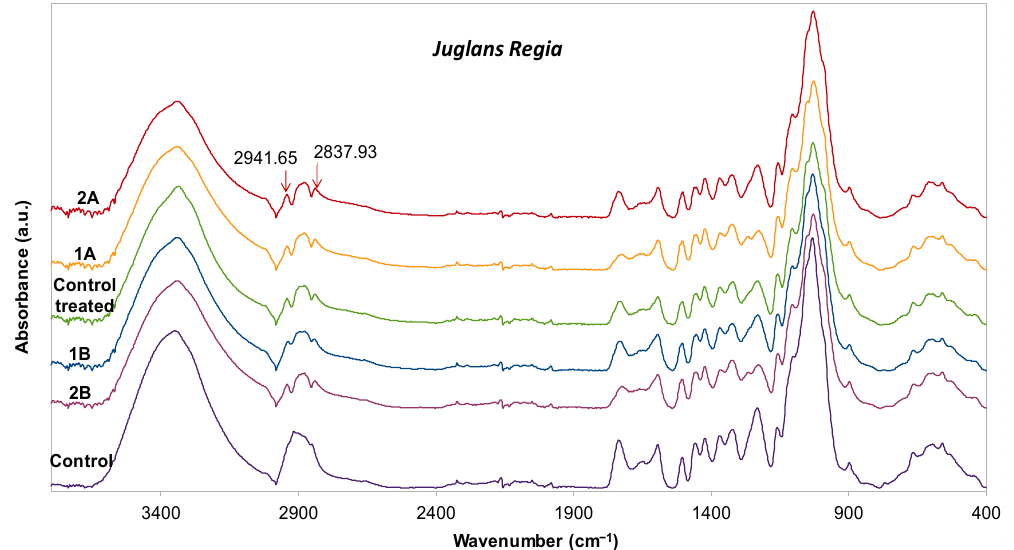
Figure 3. Spectral band assignments of the main spectral peaks observed in the walnut wood FTIR spectra. 1A—Fe 2 O 3 ;